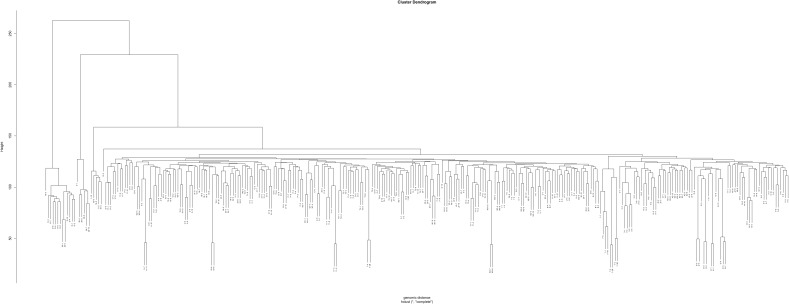
Technical replicate dendrogram.Dendrogram based on genomic distance between samples showing the strong clustering of technical replicates (denoted with an ‘R’ after the sample name and highlighted in yellow). Note that three of the technical replicates failed to pass quality control and are not included in the dendrogram. Additional sample pairs show strong clustering. In each of these cases, the individuals of the pair are from the same sampling site, indicating samples that are closely related.